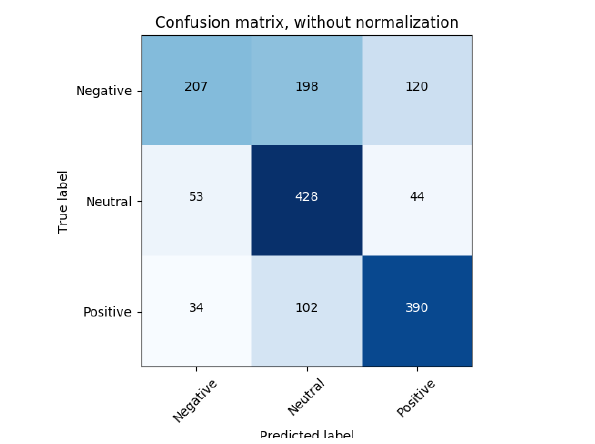
Figure 3. Confusion matrix for VGG16 network (learning rate=0.00001, batch=5, epochs=100).